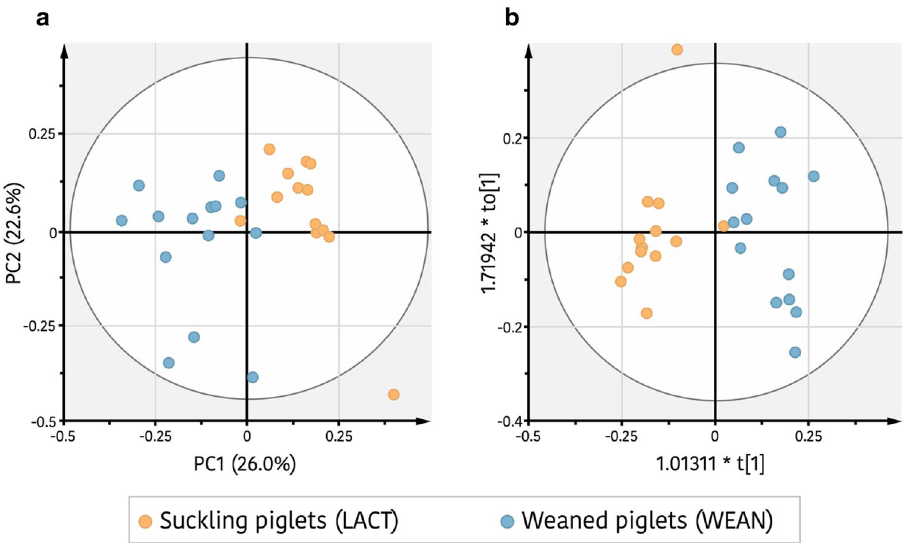
Figure 5. Weaning effect on serum metabolic profile of the piglets. ( a ) Principal components analysis (PCA) score plot of serum metabolites set from suckling piglets (orange) and weaned piglets (blue). ( b ) Orthogonal partial least squares discrimination analysis (OPLS-DA) score between suckling piglets (orange) and weaned piglets